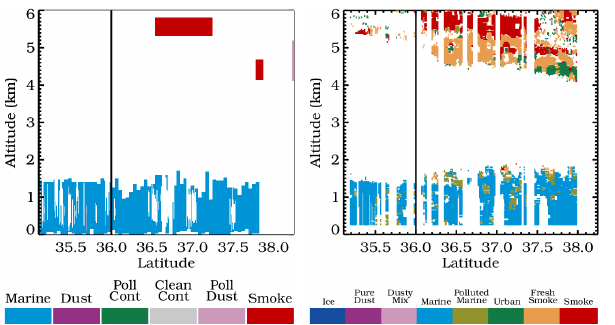
Fig. 3. Aerosol classification masks from CALIOP (left) and HSRL-1 (right) for a nighttime scene off the coast of Virginia and North Carolina on 25 June 2006, showing a tenuous elevated smoke layer and the marine boundary layer. Transit time for HSRL-1 on the B200 was 53min compared to 52s for